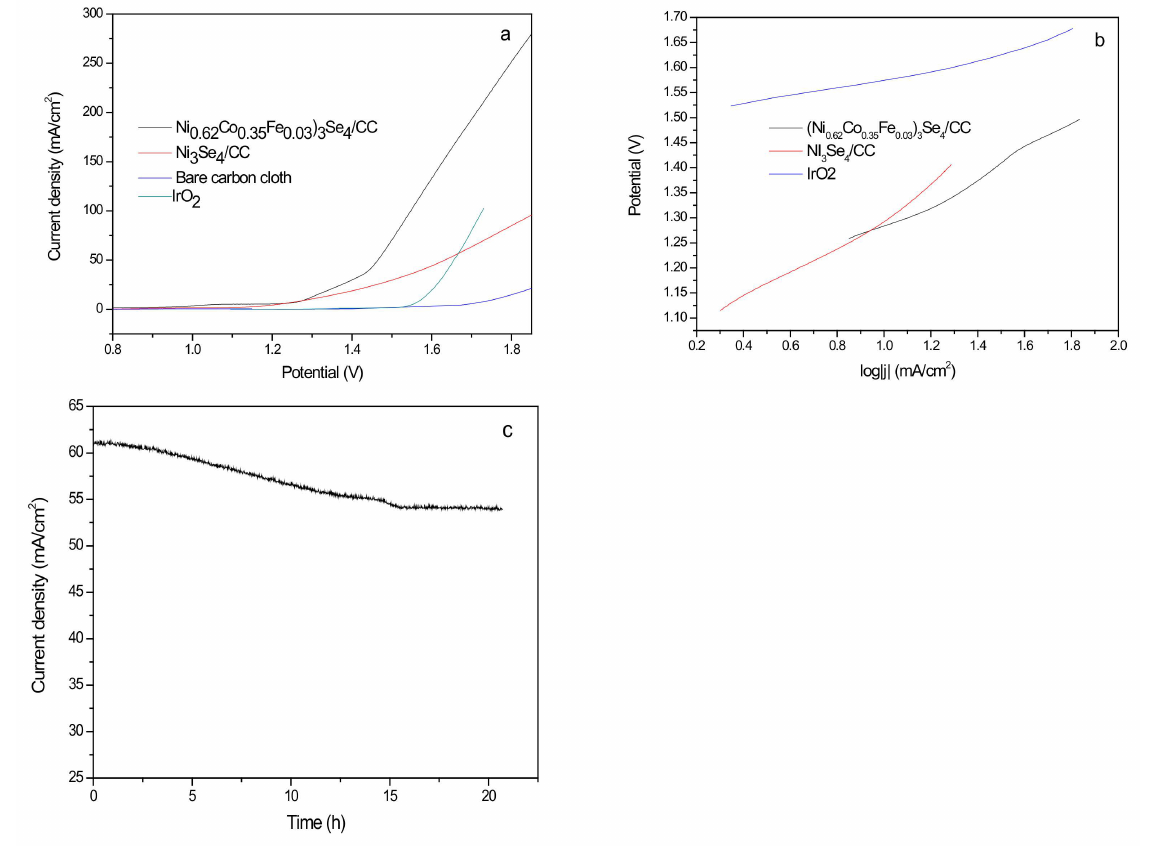
Figure 7. ( a ) OER LSV curves of (Ni 0.62 Co 0.35 Fe 0.03 ) 3 Se 4 /CC, Ni 3 Se 4 /CC; ( b ) corresponding Tafel plots; ( c ) Chronopotentiometry of (Ni 0.62 Co 0.35 Fe 0.03 ) 3 Se 4 /CC. All tests were performed in 1 M KOH electrolyte, relative to RHE 1.5